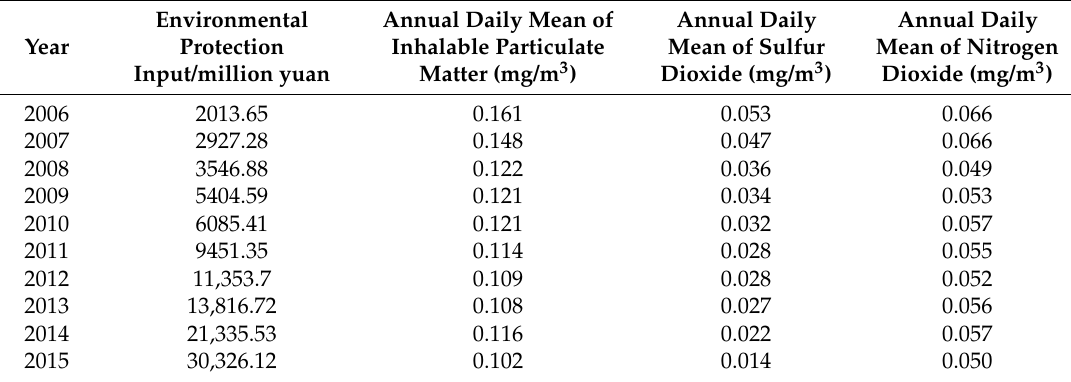
Table 1. Financial input for environmental protection and the changes of three air pollutants in Beijing from 2006 to